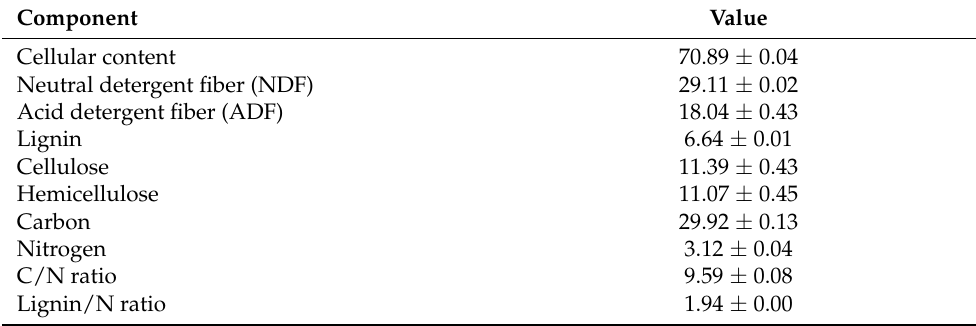
Table 1. Fiber fraction composition and C and N content of Ulva ohnoi (% w / w on a dry basis). Component Value Cellular content 70.89 ± 0.04 Neutral detergent fiber (NDF) 29.11 ± 0.02 Acid detergent fiber (ADF) 18.04 ± 0.43